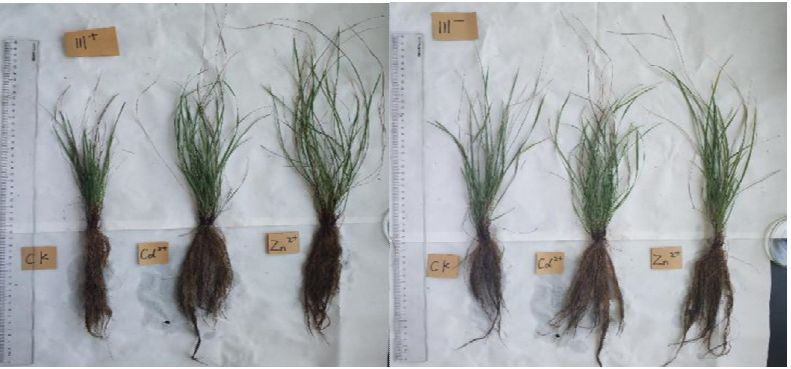
Figure 2. Photos showing comparative phenotypes of E+ and E- plants under different treatments after harvesting.